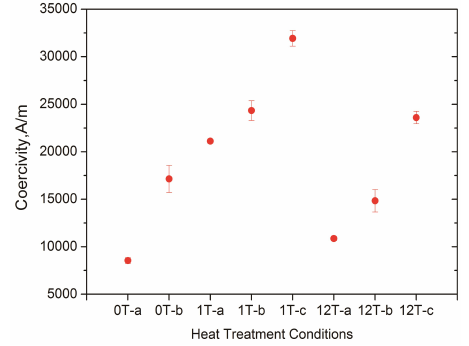
Figure 5. Coercivity of Fe ‐ Cr ‐ Co alloys subjected to different thermomagnetic treatments: Horizontal ordinate shows the conditions of thermomagnetic treatments, where 0 T, 1 T, and 12 T denote the magnetic flux density in the annealing process; a and b denote one ‐ and two ‐ step aging without HMF, respectively; c denotes step aging twice in an HMF, with the same magnetic flux density that was applied during its annealing process.